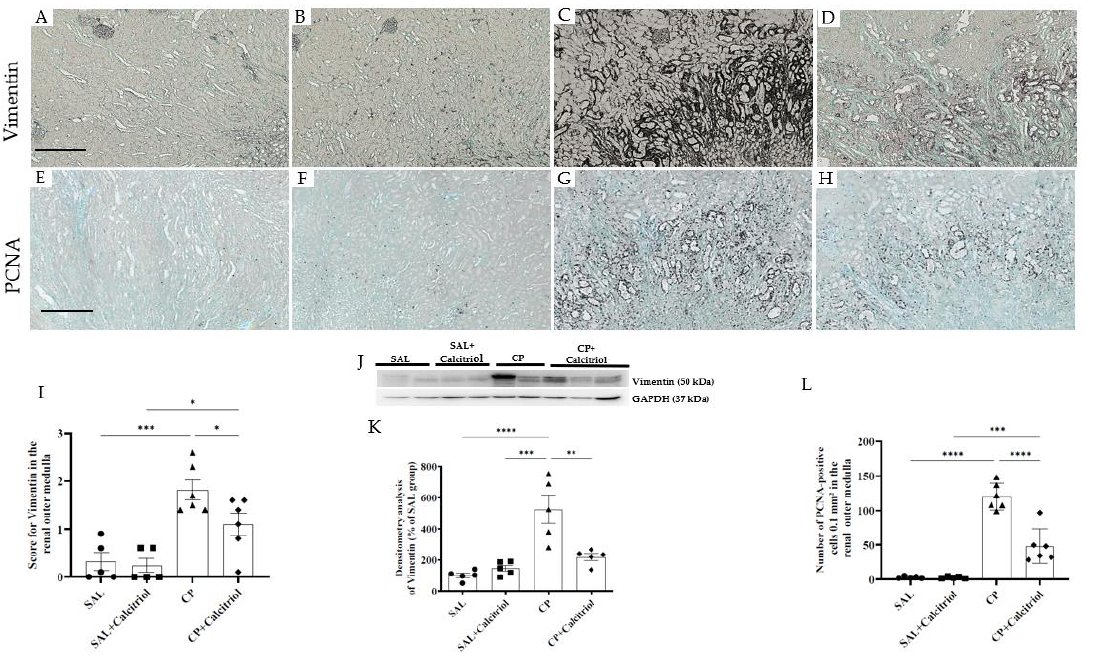
Figure 2. Immunolocalization of vimentin ( A – D ) and PCNA ( E – H ) in the renal outer medulla of the SAL ( A , E ), SAL + calcitriol ( B , F ), CP ( C , G ) and CP + calcitriol ( D , H ) groups. The bar indicates 200 µ m. The score for vimentin ( I ) and the number of PCNA+ cells ( L ) in the renal outer medulla in the different groups. Western blot analysis of vimentin and GAPDH ( J ) in the renal tissue from all experimental groups (SAL, SAL + calcitriol, CP, CP + calcitriol). Vimentin densitometry ( K ). The densitometric ratio between vimentin and GAPDH was calculated, and data are expressed in comparison with the control group, with the mean control value ( ± SEM) designated as 100% and expressed as mean ± SEM ( n = 5–8 for each group). Blots are representative images of independent experiments. * p < 0.05; ** p < 0.01; *** p < 0.001; **** p < 0.0001: magnification, × 100.